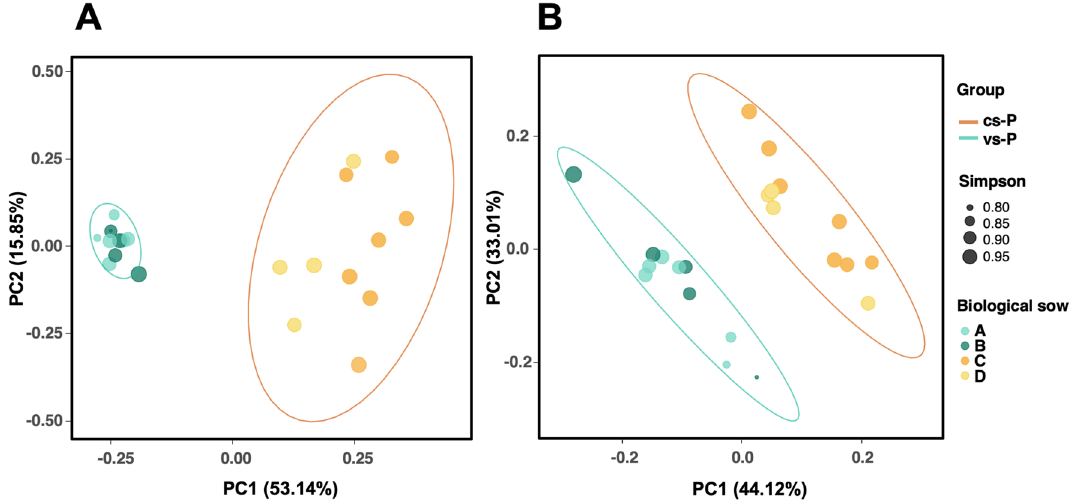
Figure 2. PCoA plots representing the beta diversity of the nasal microbiota of piglets from vaccinated (green) and control unvaccinated sows (orange). Bray Curtis distance matrix is represented in the left ( A ) and weighted Unifrac index on the right ( B ). Each sample is colored based on the biological sow, and the size of the symbol is proportional to the Simpson index (alpha diversity).